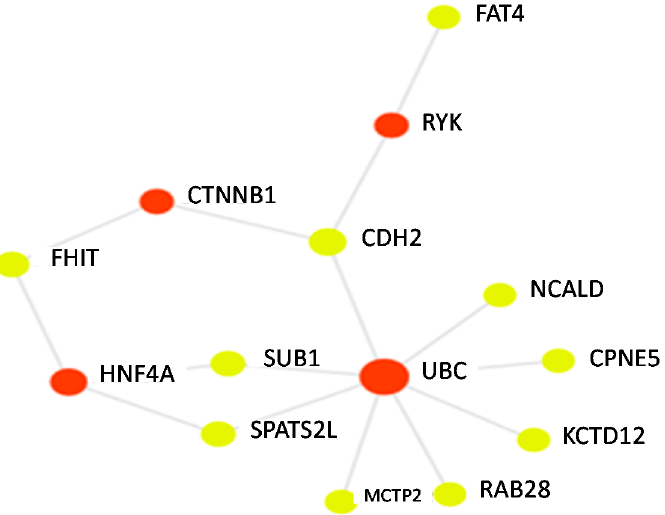
Figure 1. A gene protein network connecting seed genes (yellow nodes) represented in the PRS with each other and with relevant proteins (red-nodes).